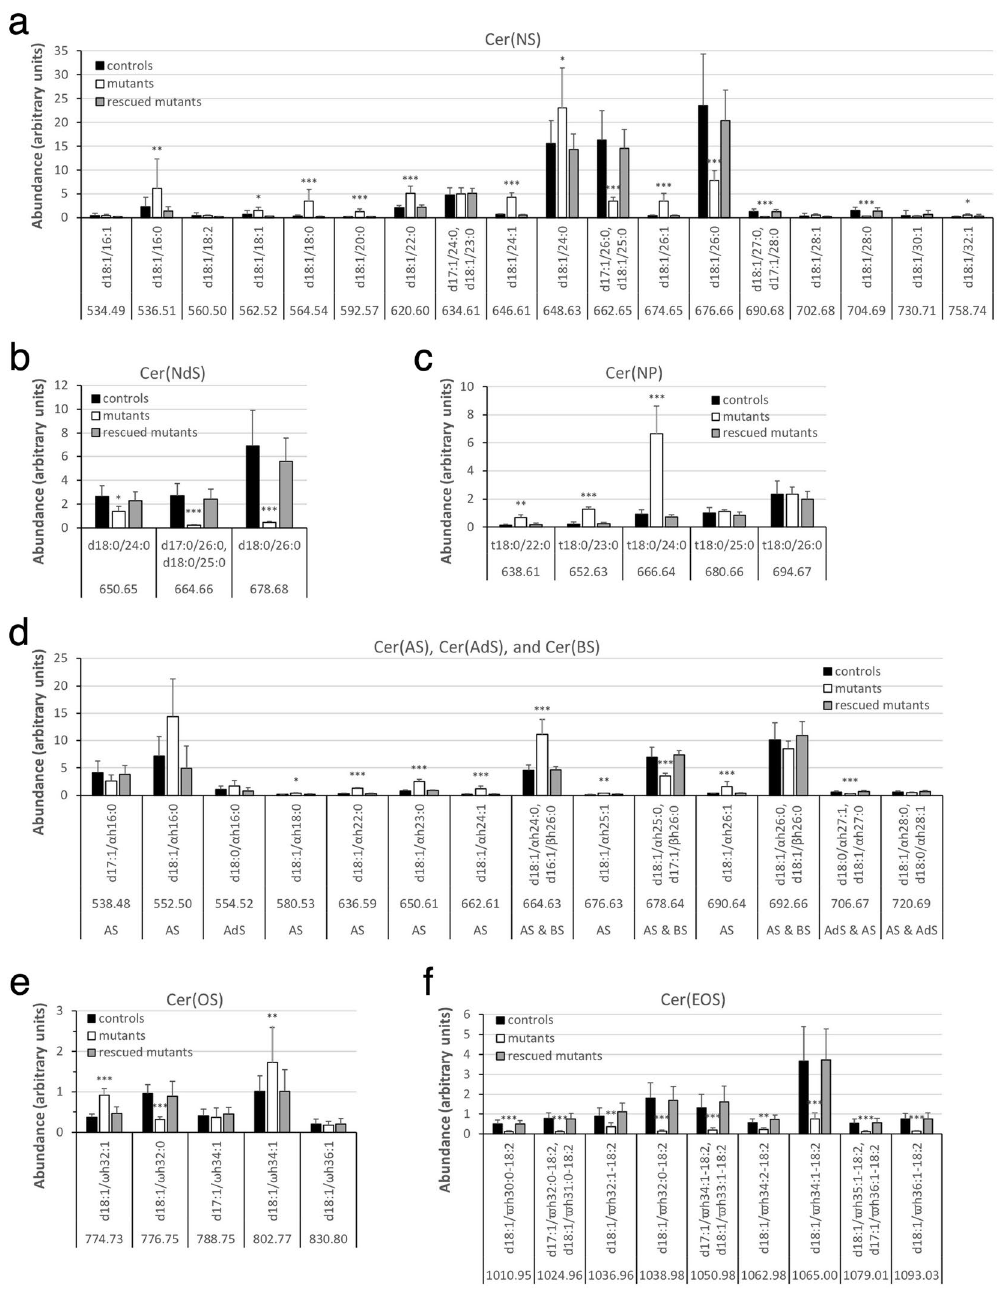
Figure 7. Alterations in ceramide content in unbound epidermal lipids in Fatp4 − / − mice. Fraction 3 of unbound epidermal lipids of newborn mice was analyzed by ESI-MS as [M − H] − ions in the negative-ion mode and quantified in arbitrary units. Fatp4 − / − mice showed a shift to the Cer(NS) species with a shorter saturated acyl chain ( a ), decreased levels of the Cer(NdS) and Cer(OS) species that contained a saturated acyl chain ( b , e ) and of all Cer(EOS) species ( f ), and increased levels of several species in Cer(NP) and Cer(AS) ( c , d ). These defects were all normalized by the Fatp1 transgene. Data were obtained from 4 each of Fatp4 + / − (controls), Fatp4 − / − , and FATP1-rescued mutants with m/z ratios, standard deviation, and statistical significance shown ( * P < 0.05; ** P < 0.01; *** P < 0.001). See Materials and Methods for